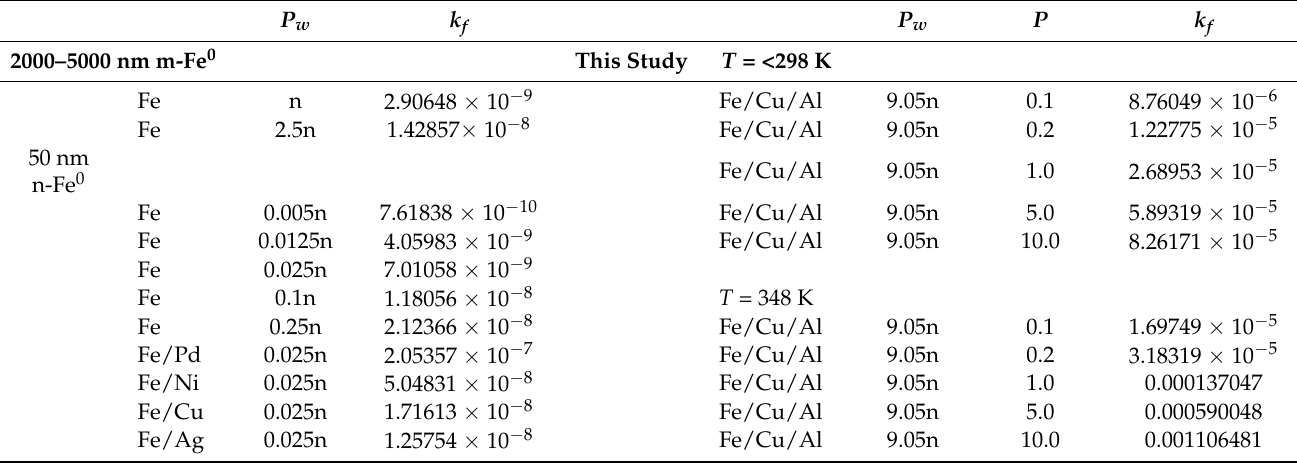
Table 24. Comparison of hydrogen production rates in this study and previous studies. P =